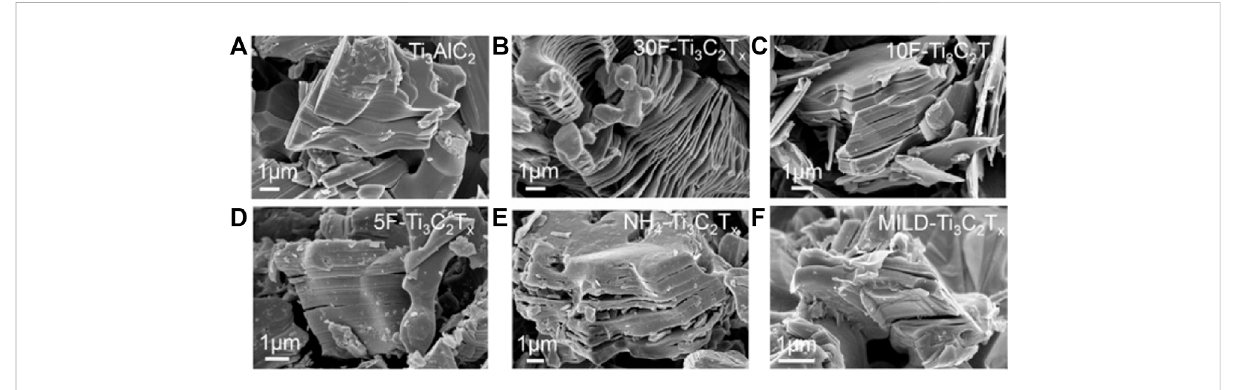
FIGURE 4 SEM image of (A) Ti 3 AlC 2 (MAX) powder showing the compact layered structure. Multilayered Ti 3 C 2 T x powder synthesized with (B) 30 wt%, (C) 10 wt%, and (D) 5 wt% HF. Accordion-like morphology only observed for the 30 wt% HF etched powder (B) . (E) Multilayered NH 4 -Ti 3 C 2 T x powder